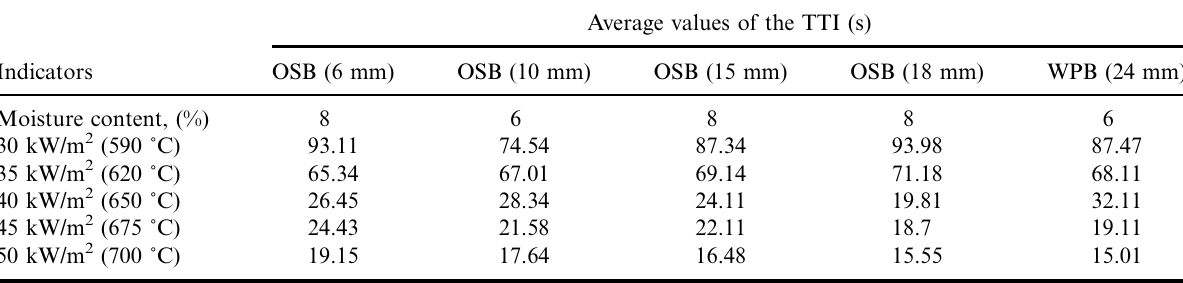
Average values of the TTI (s)